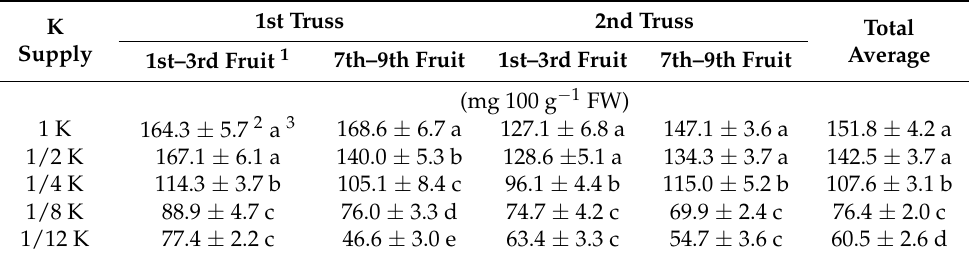
Table 4. Fruit K content of hydroponically grown cherry-type tomato ‘Carol 10’ under five quantita- tive K-supply